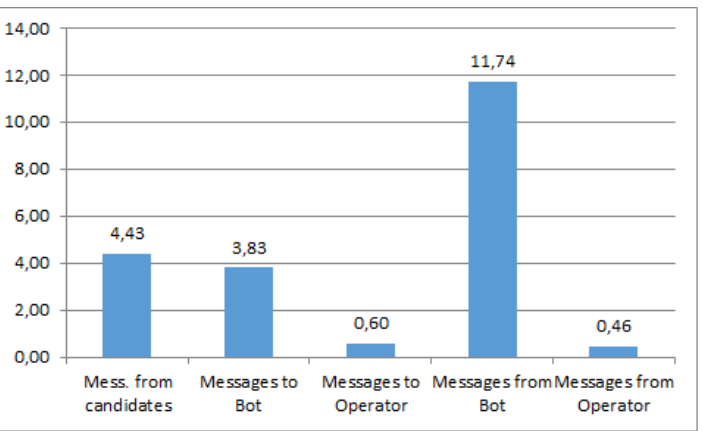
Figure 14. The number of messages from the candidates, from the bot, from the operator and the number of chats to the operator and to the bot.